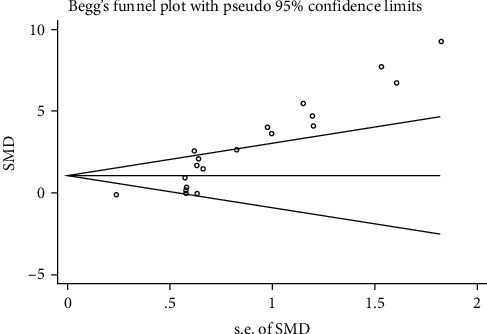
Publication bias.